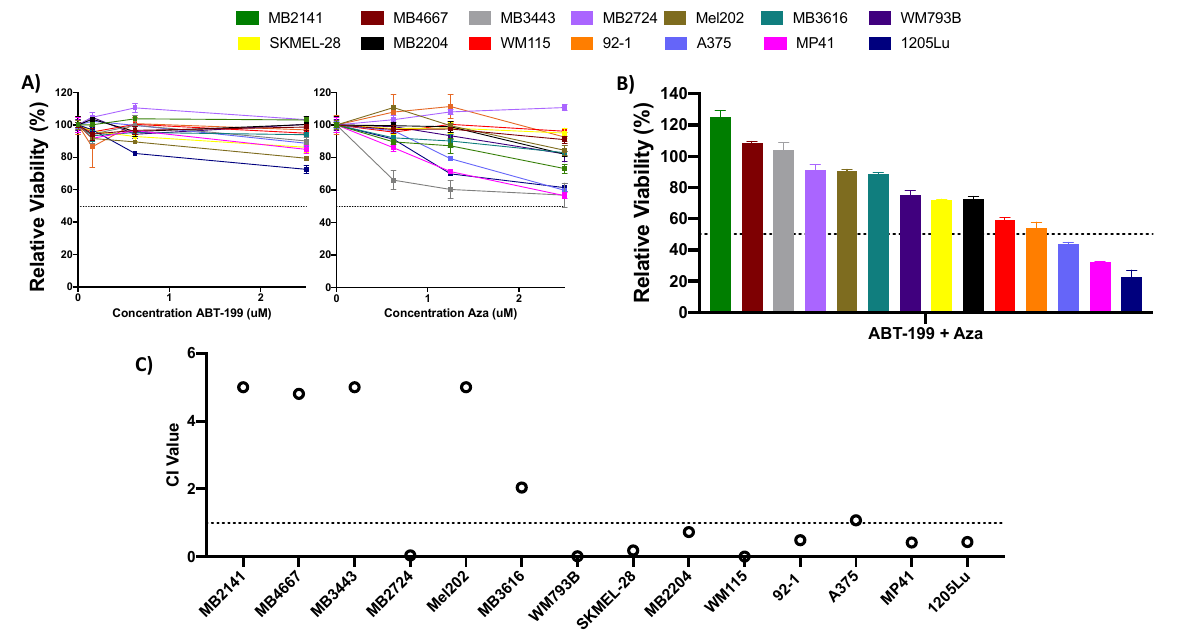
Figure 1. Single agent or combination treatment with ABT-199 and azacitidine (AZA) is ineffective in melanoma cell lines. ( A , B ) ATP assay of melanoma cell lines after 48 h of treatment with single agent AZA or ABT-199 ( A ), or their combination ( B ). Combination treatment was treated at 2.5 uM. Black dotted line indicates viability of 50%. Y axis indicates viability relative to DMSO control, set to 100%. X axis indicates drug treatment. Error bars represent +/ − SEM. ( C ) Plot of the combination index (CI) values for the ABT-199 + AZA combination at 2.5 uM concentration. CI values were calculated using the CompuSyn software (version 1). CI values >1 indicate antagonism, values 0.9–1 indicate an additive effect, and values <0.9 indicate synergy. For clarity, values >5 are cutoff at 5. Black dotted line indicates CI value of 1. Y axis indicates CI value, X axis indicates cell line. Table 1. Genotype and subtype of commercially available or patient derived cell lines